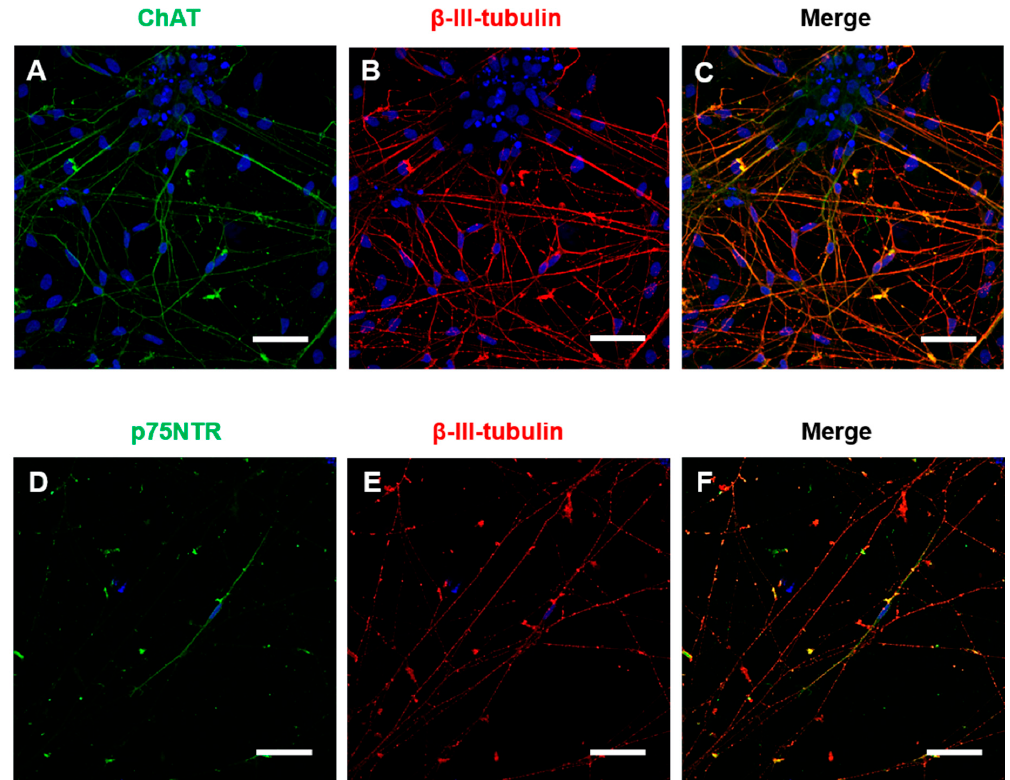
Figure 2. BFCNs were positive for neuronal markers. BFCN cultures were matured for 4 weeks and immunocytochemistry for general neuronal markers and specific cholinergic neuronal markers was performed. ( A–F ) Representative confocal pictures of the BFCN cultures at week 4 of BFCN maturation with the nuclear marker Hoechst 33,342 in blue. ( A ) Cholinergic marker ChAT in green. ( B ) Neuronal marker β -III-tubulin in red. ( C ) Merged picture of A and B. ( D ) Cholinergic marker p75NTR in green. ( E ) Neuronal marker β -III-tubulin in red. ( F ) Merged picture of D and E. Scale bars = 50 μ m.